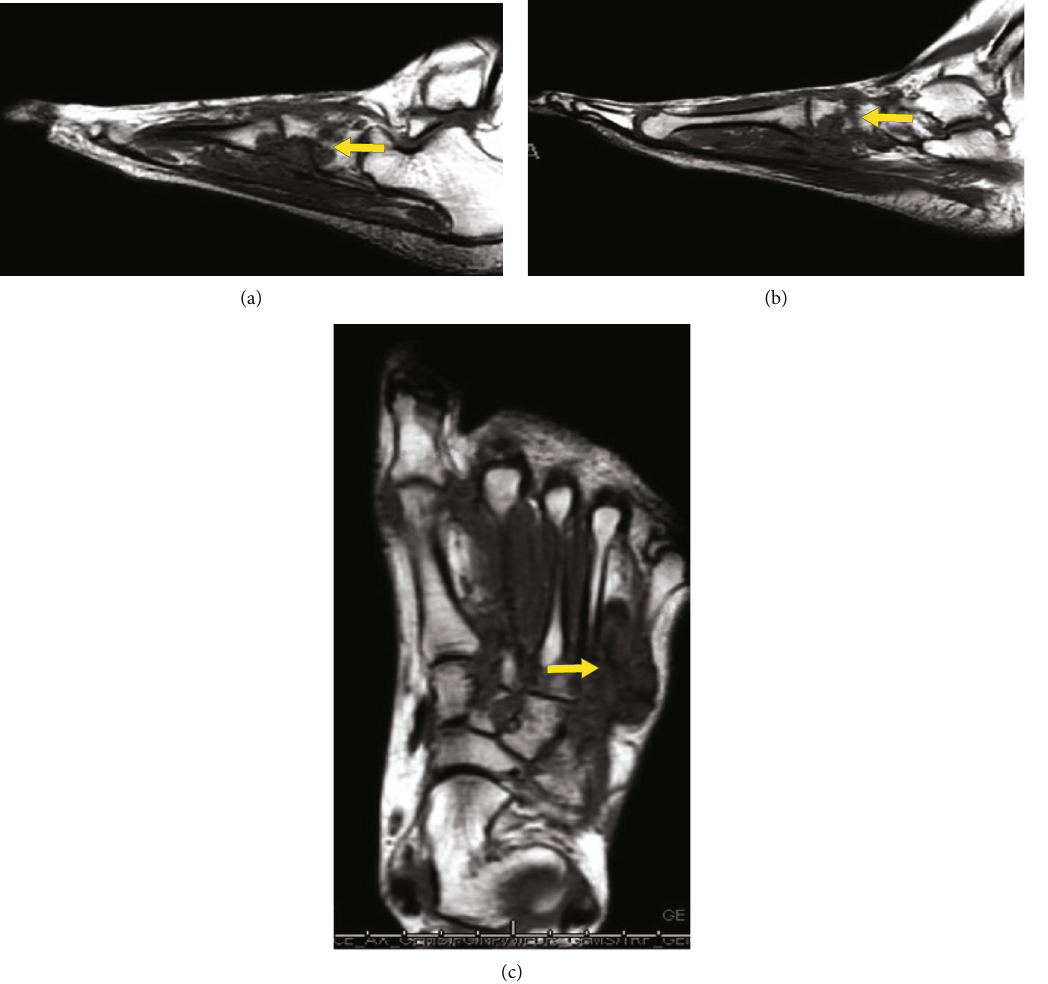
Figure 9: Sagittal and axial images of a 35-year-old female with D-TGCT in the foot. Sagittal T1 weighted images (a, b) (arrow) and axial T1 weighed image (c) (arrow) demostrating stable involvement of the forefoot and midfoot with known history of D-TGCT on serial imaging.